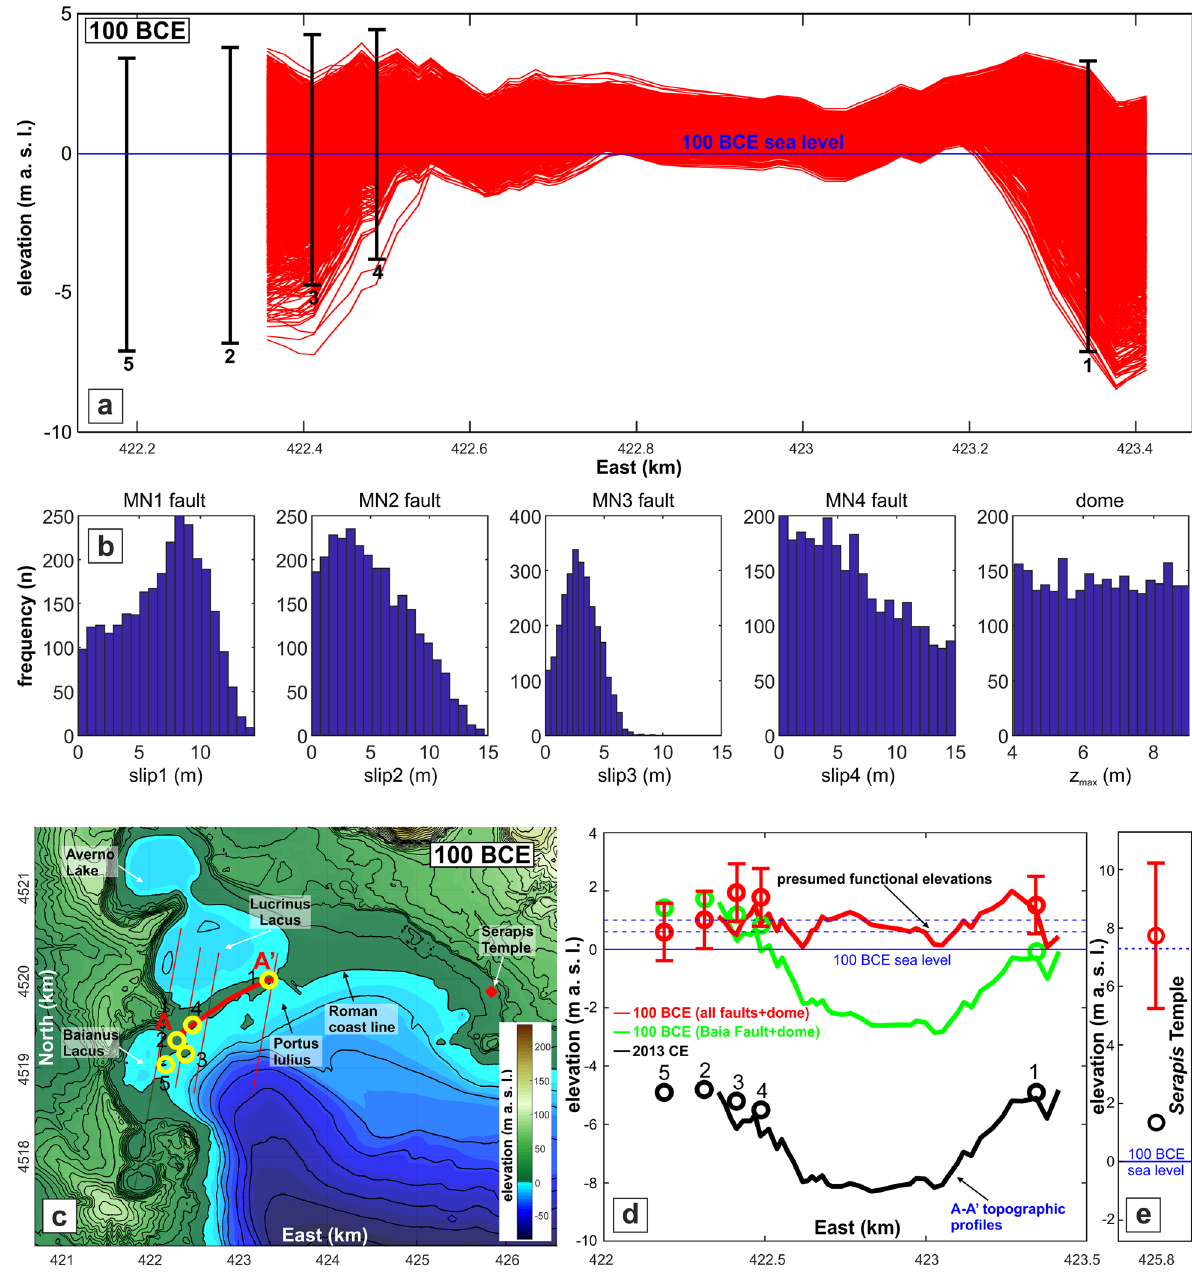
Fig. 7 Monte Carlo simulation: a restoration of archaeological data (1–5) and A–A’ profile (Via Herculanea ); b frequency histograms of the fault slips (in metres) and dome deformation ( z max in metres). c 2D topographic reconstruction after restoring the ground deformation associated with all faults and dome activity with mean values resulting from the Monte Carlo simulation. d Elevation of the archaeological sites (red circles) and A–A’ profile (red curve) using the mean values resulting from the Monte Carlo simulation. The diagram also shows the 2013 elevations (black circles and curve) and the 100 BCE elevations (green circles and curve), considering only the Baia Fault and dome restoration. e Elevations of the Serapis Temple: in 2013 (black circle) and in 100 BCE (red